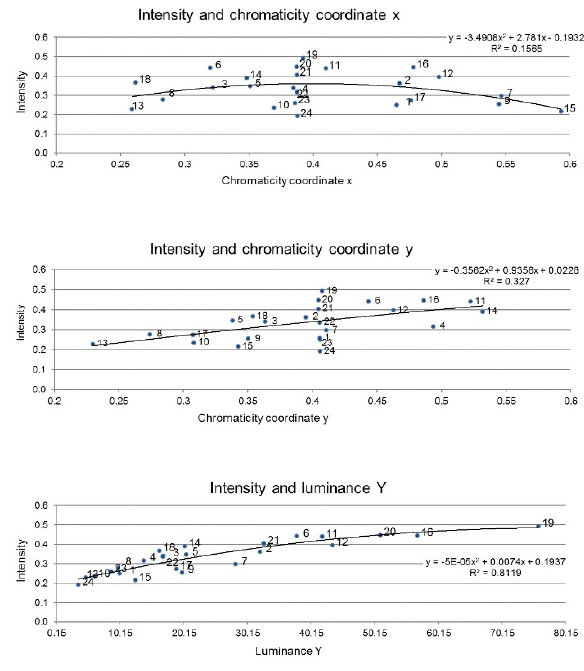
Figure 3. Relationship between intensity and CIE xyY coordinates